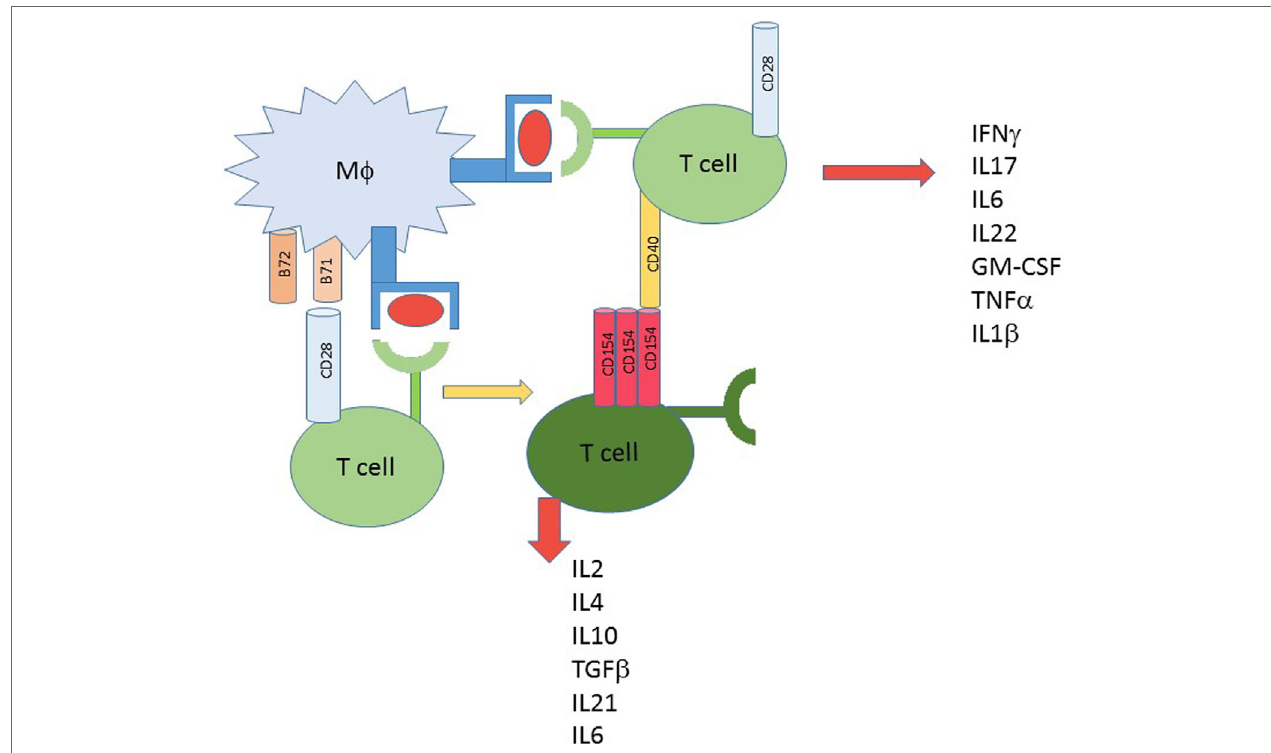
FiGURe 1 | T cell activation alternative methods. Classic 2 signal activation involves T cell interaction with antigen presenting cell. Signal one is antigen dependent and delivered to the T cell receptor by MHC/HLA and antigen. The costimulus can include CD28 interacting with B71 or B72; that outcome creates activation leading to cytokine production. When a source of CD154 is available, including from the newly activated T cells, other T cells receive a different second signal costimulus to produce inflammatory type cytokines. CD28 signals favor more regulatory type